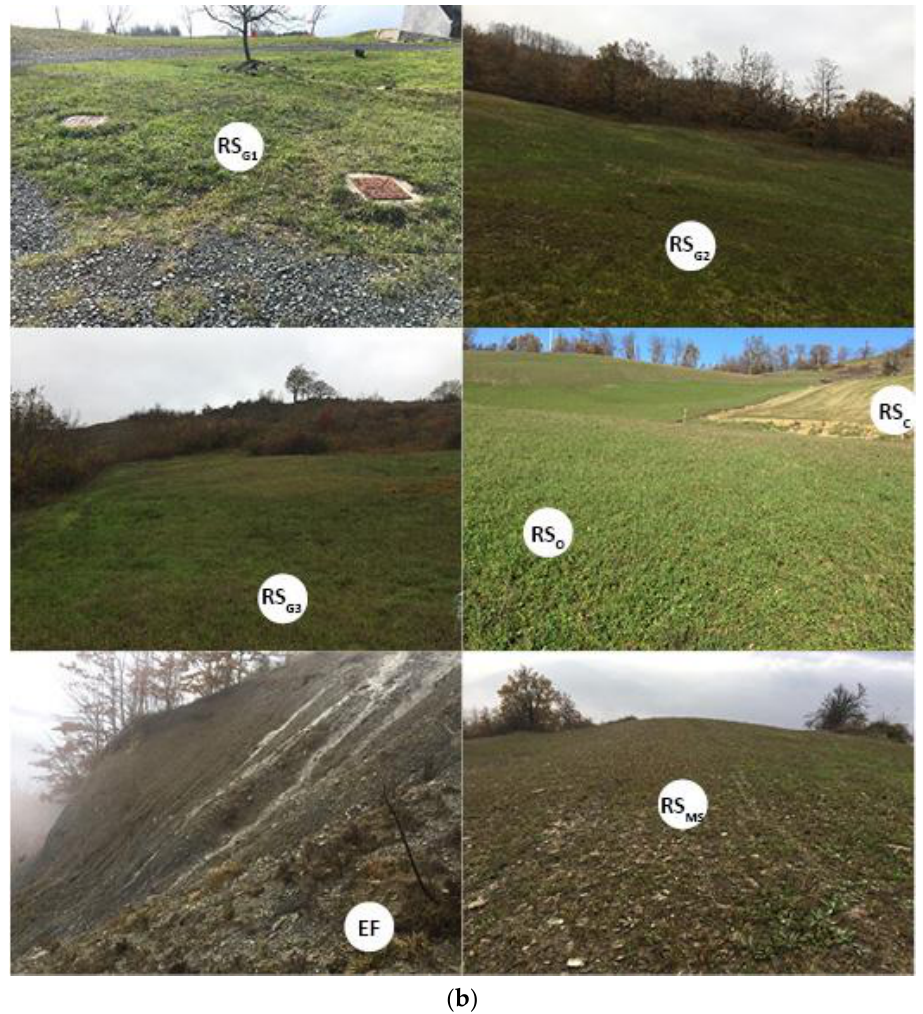
Figure 1. ( a ) Location of the piezometers (blue points), the corings (yellow points) and the soil sampling sites (red points) (the contour lines show the altitude in meters above sea level); ( b ) Sampling sites: RS G1 : Rotational Slide-Grassland 1; RS G2 : Rotational Slide-Grassland 2; RS G3 : Rotational Slide-Grassland 3; RS O : Rotational Slide-Overgrown; RS C: and Rotational Slide-Cultivated; EF: Earth Flow; RS MS : Rotational Slide-Main Scarp.